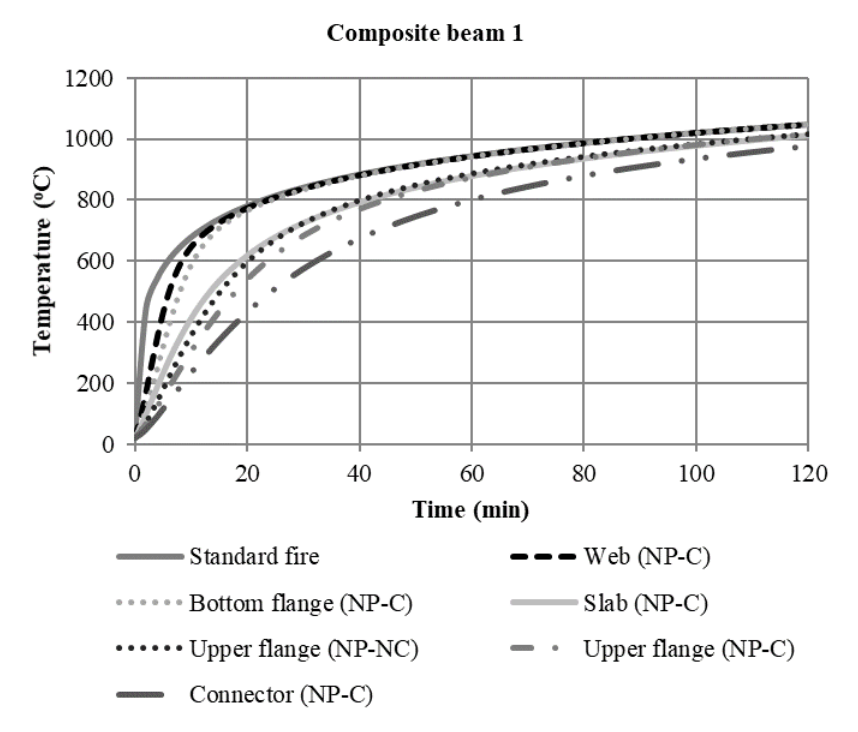
Figure 9. “Temperature x time” curves of the parts of the composite beam 1 and standard